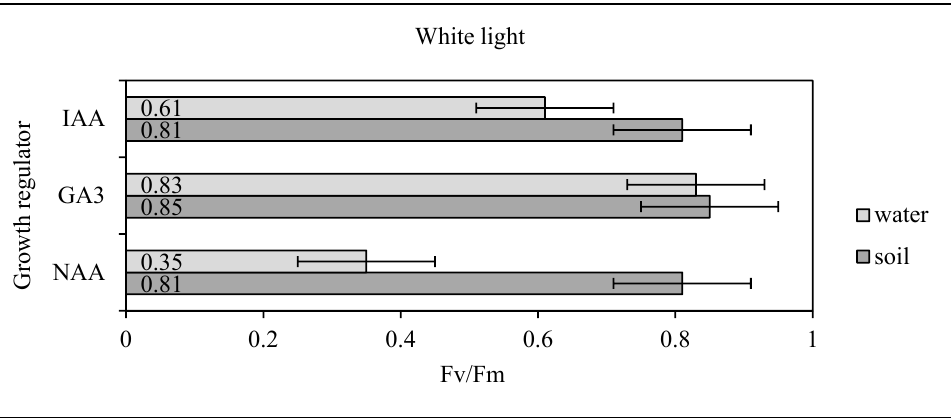
Figure 2. Efficiency of photosystem II photochemistry (Fv/Fm) for Scots pine seedlings germinated in white light. Vertical bars indicate the standard deviation. IAA—indole-3-acetic acid, GA 3 —gibberellic acid, NAA—1-naphthaleneacetic acid.